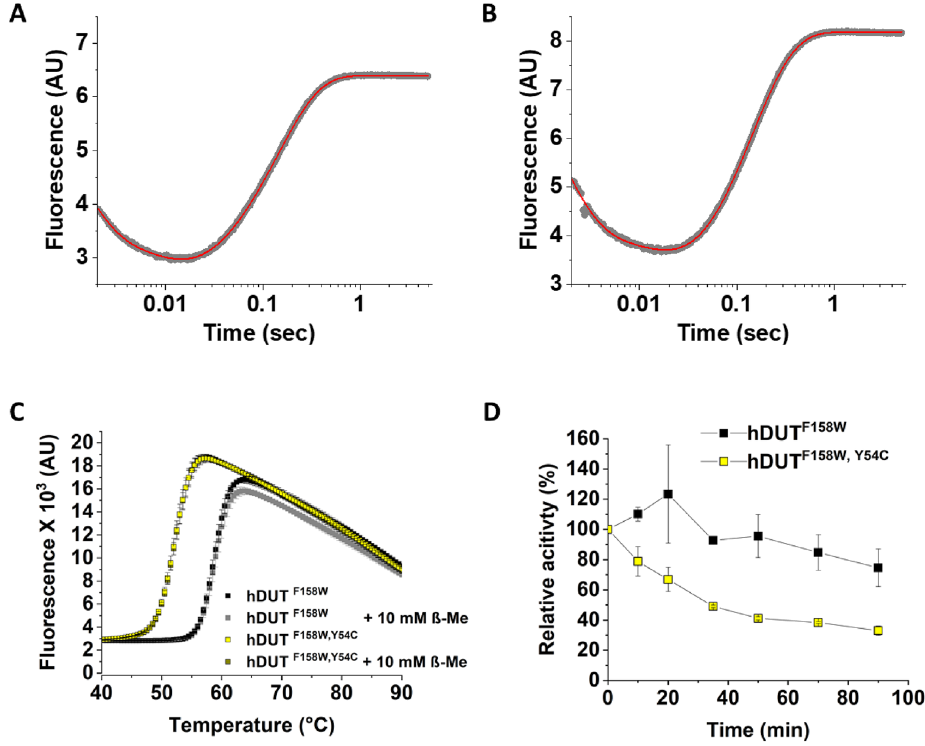
Figure 4. ( A–B ) Representative single turnover fluorescence reaction curves of hDUT F158W,Y54C in the presence ( A ) and in the absence ( B ) of 10 mM β-ME. The reaction curves were fitted with triple exponential function (Eq. 1) which yielded the following parameters A 1 = 3.20 ± 0.14, A 2 = 1.2 ± 0.01, A 3 = -4.02 ± 0.003, k 1 = 877.8 ± 23.9, k 2 = 118.8 ± 1.4, k 3 = 7.0 ± 0.01, y 0 = 6.40 ± 0.0006 for Panel A and A 1 = 4.61 ± 0.12, A 2 = 1.74 ± 0.01, A 3 = − 5.70 ± 0.52, k 1 = 728.9 ± 13.1, k 2 = 61.4 ± 0.01, k 3 = 6.9 ± 0.01, y 0 = 8.18 ± 0.001 for Panel B (the errors represent the error of the fitted parameters). Several (3–5) single turnover reaction curves were recorded, and the average and standard deviation of the resulted parameters are shown in Table 1. ( C ) Differential Scanning Fluorimetry measurements of the hDUT F158W and hDUT F158W,Y54C proteins in the presence and absence of 10 mM β-ME. Melting temperatures are given in Table 1. ( D ) Stability measurement of the hDUT F158W and hDUT F158W,Y54C proteins. Results of steady-state initial velocity measurements with fixed concentration of dUTP after incubation at 37 °C for various time